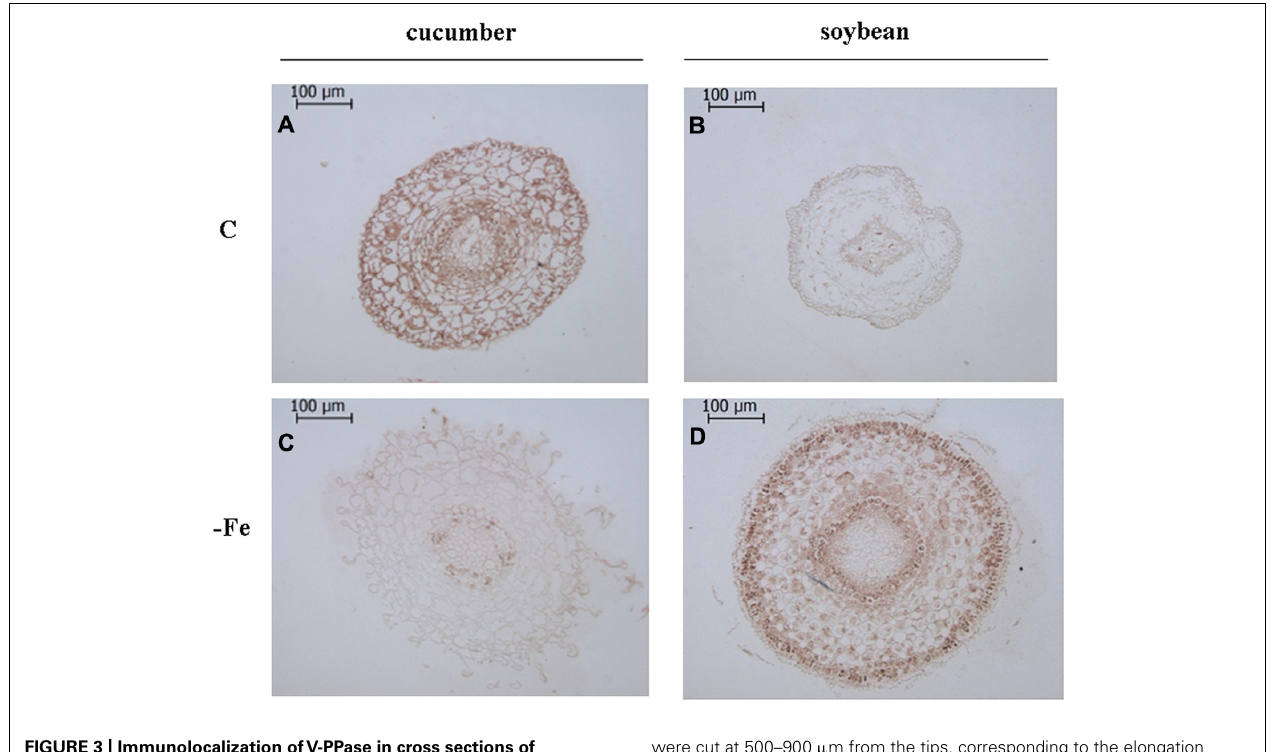
were cut at 500–900 μ m from the tips, corresponding to the elongation zone.The sections treated without the primary antibody appeared not stained, indicating the absence of any aspecific reaction (data not